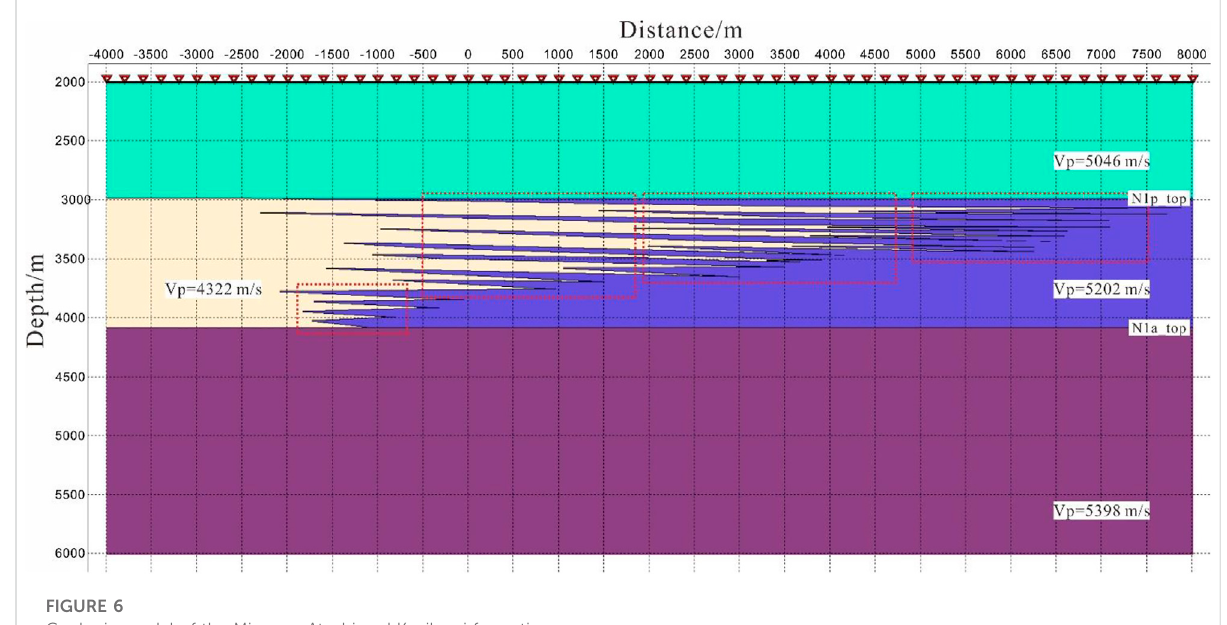
FIGURE 6 Geologic model of the Miocene Atushi and Keziluoyi formations.